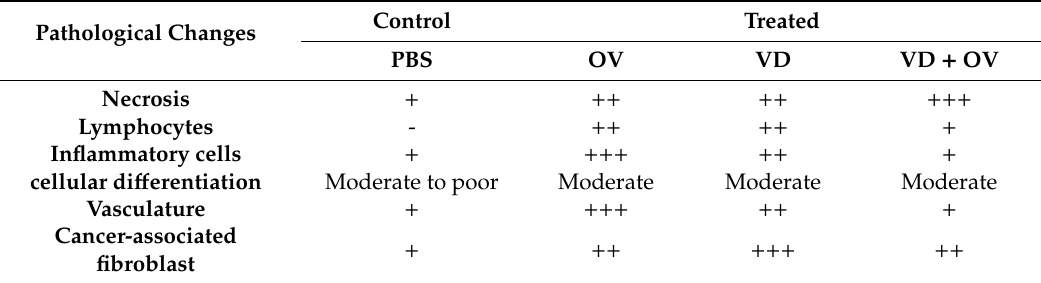
Table 1. Summary of Pathological Changes.